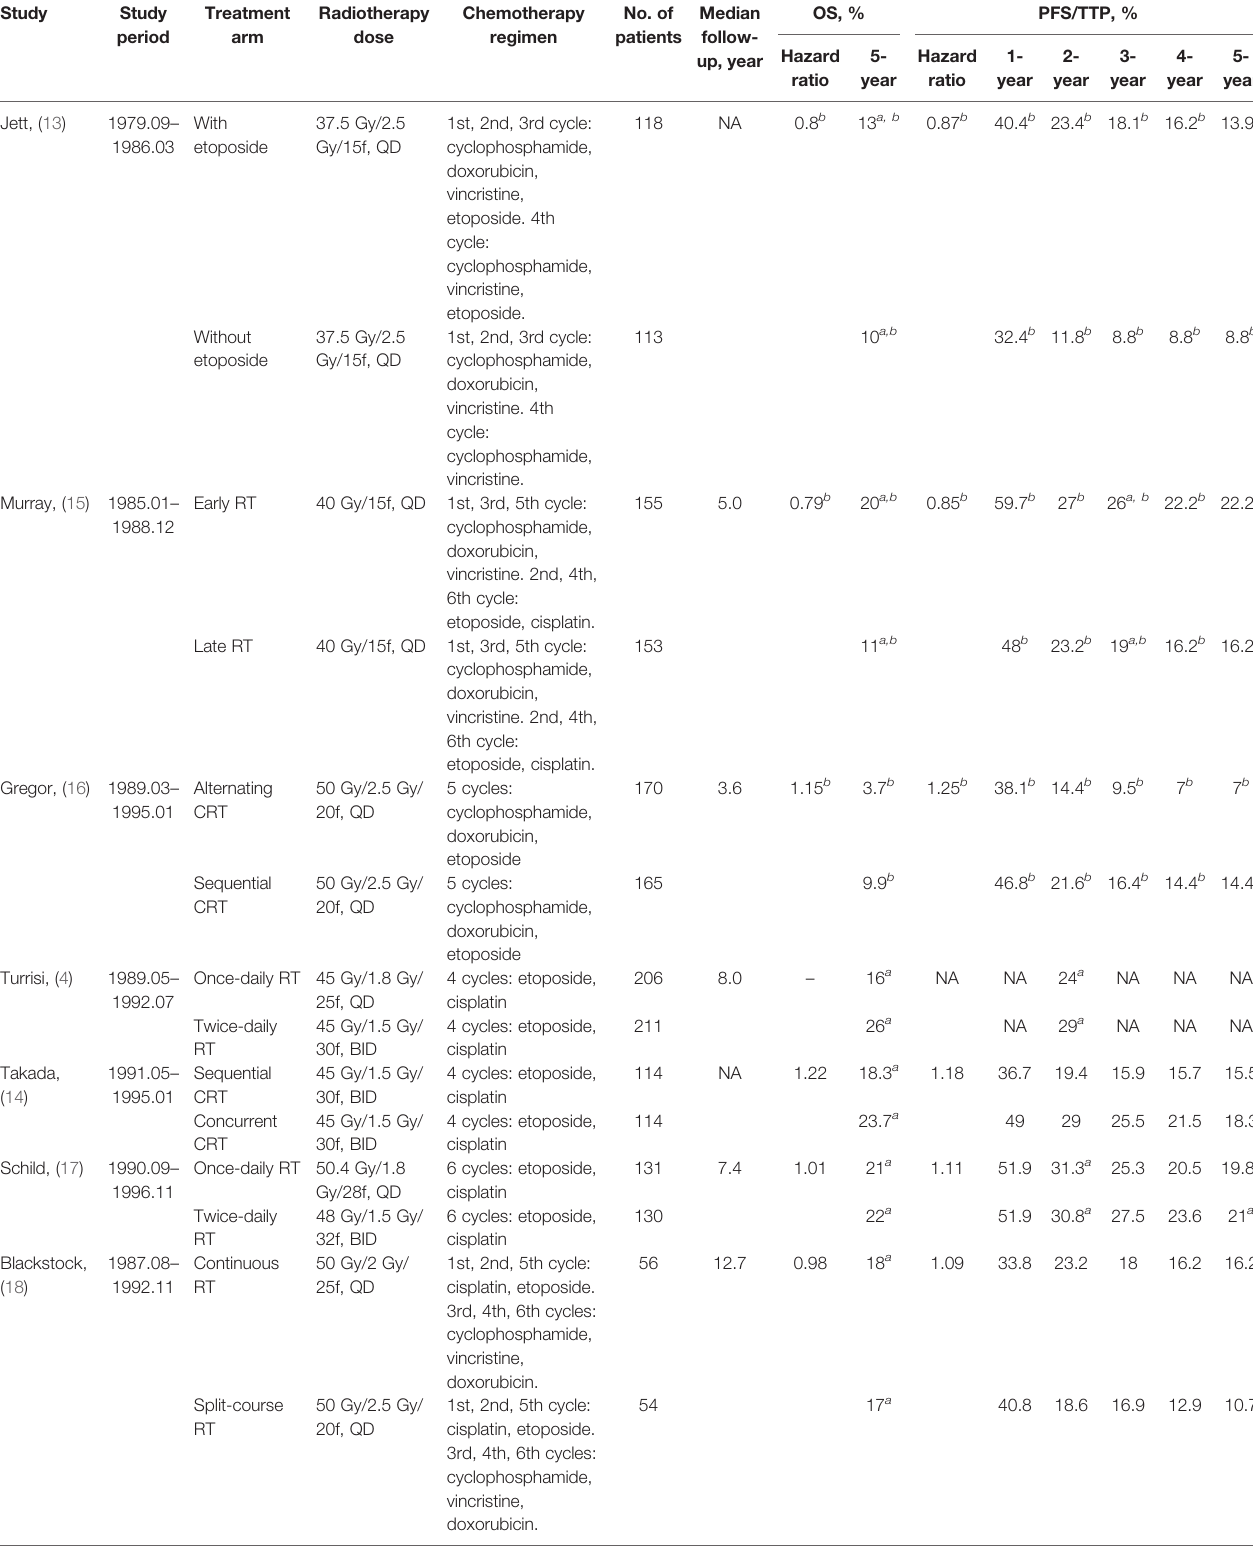
TABLE 1 | Summary of 15 phase III randomized controlled trials included in the current